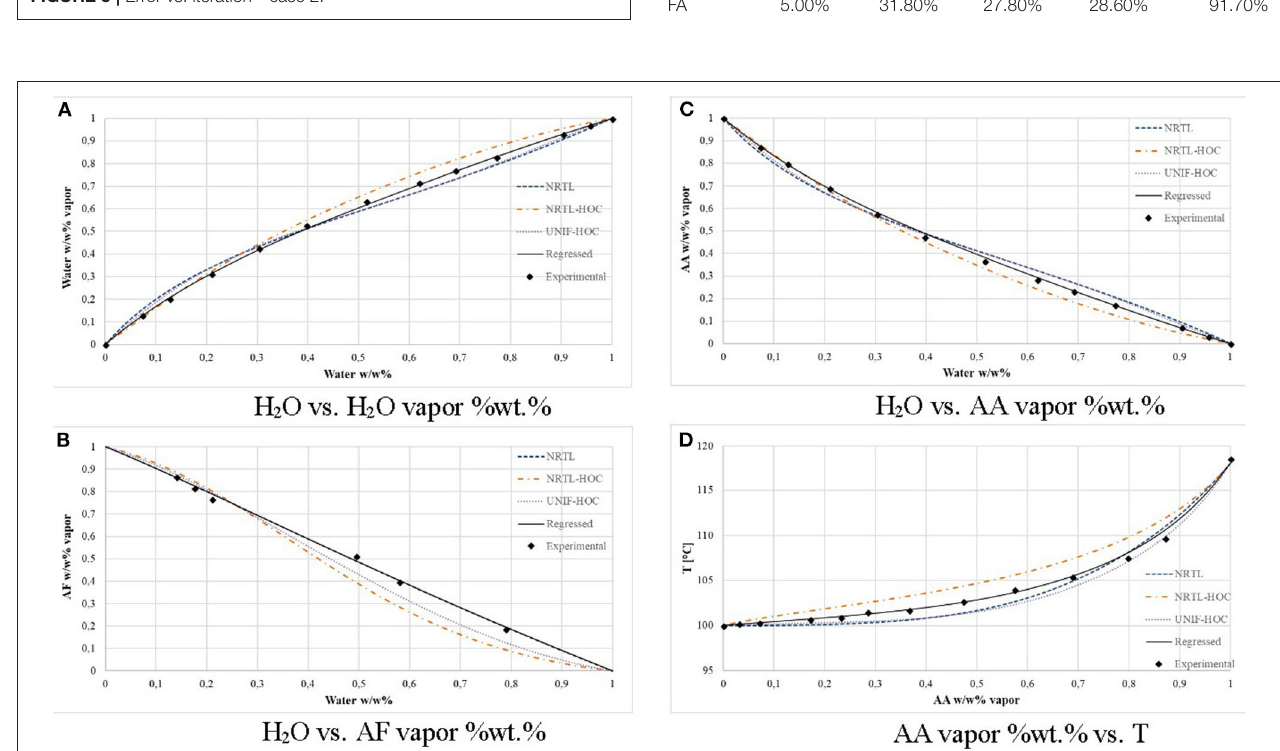
FIGURE 6 | Comparison of VLE thermodynamic models. (A) H 2 O liquid vs. vapor. (B) H 2 O liquid and AF vapor. (C) H 2 O liquid and AA vapor. (D) AA vapor as a function of T.